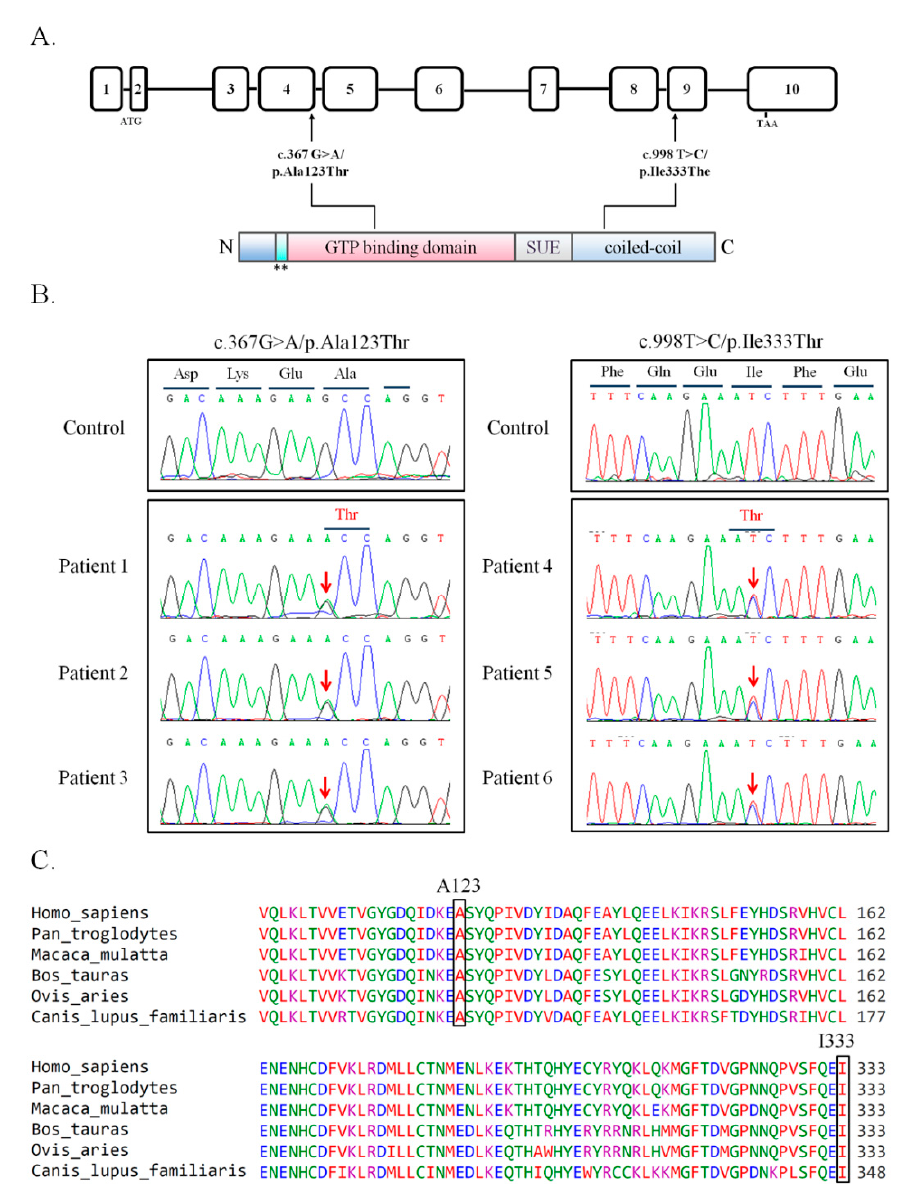
Figure 1. Identification of novel SEPT14 missense mutations associated with male infertility. ( A ) Schematic of the SEPT14 gene (upper panel) and protein (lower panel). Two missense mutations, A123T and I333T, were observed in patients with teratozoospermia. A123T was located in the GTP-binding domain, and I333T was located in the C-terminal coiled-coil domain. The 10 exons of the human SEPT14 were numbered, and the start and stop codons were annotated. N = N-terminal; ** = phosphoinositide-binding polybasic region; SUE = septin unique element; C = C-terminal. ( B ) Sanger sequencing chromatograms of SEPT14 mutations. Chromatograms display the sequence corresponding to WT and mutated alleles (upper and lower panels, respectively). These two mutations were noted in three patients and were heterozygous in each patient. Red arrows indicate nucleotide changes. (C) Evolutionary conservation of the p.A123 and p.I333 residues of the SEPT14 protein. Both A123 and I333 residues are highly conserved in various mammalian species. Alignment was performed with Clustal Omega (EMBL-EBI). Key residues, namely A123 and I333, are indicated by black squares. The numbers on the left indicate the amino acid number of the SEPT14 protein sequence.